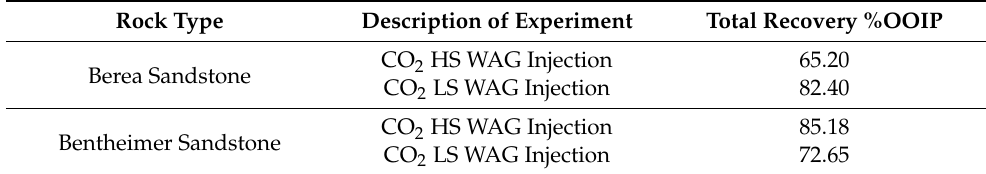
Table 6. Comparison of total recovery for Berea and Bentheimer core samples